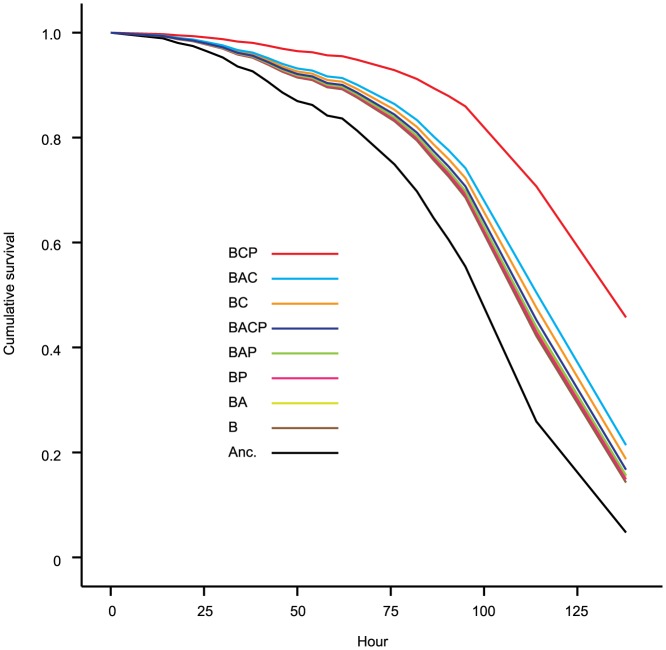
Cumulative survival curves of the fruit flies that were infected with evolved and ancestral bacterial clones.Anc.: ancestral bacterial strain DB 11; B: bacteria; A: amoebae; C: ciliate; P: phage. The survival curves represented the pooled survival data of the 480 fly individuals for each treatment (10 flies per vial, 6 clones per population and 8 replicates per treatment). The treatment codes are in the order of the increasing virulence. See Table S2 for pairwise comparisons.